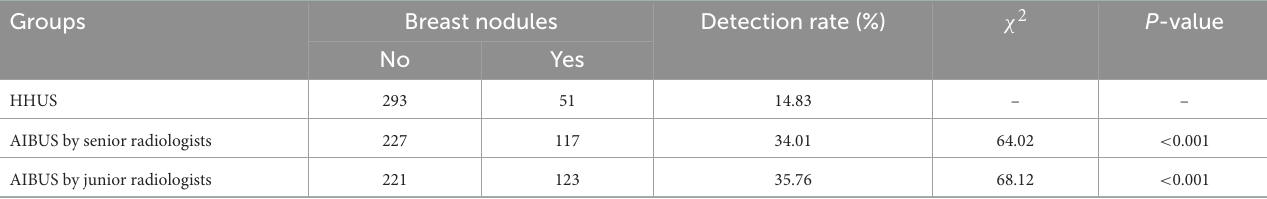
TABLE 2 Detection rates of breast nodules using HHUS and AIBUS.